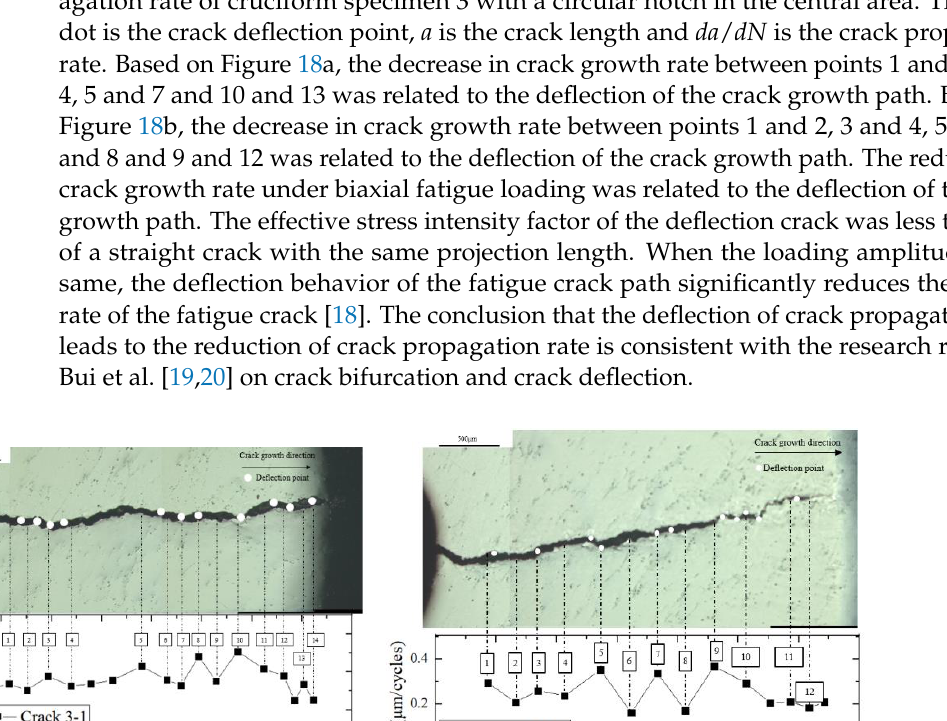
Figure 17. Variation of crack growth rate of cruciform specimen with 0° waist hole notch in the central area. ( a ) Variation of crack growth rate with crack length. ( b ) Variation of crack growth rate with cycle ratio.